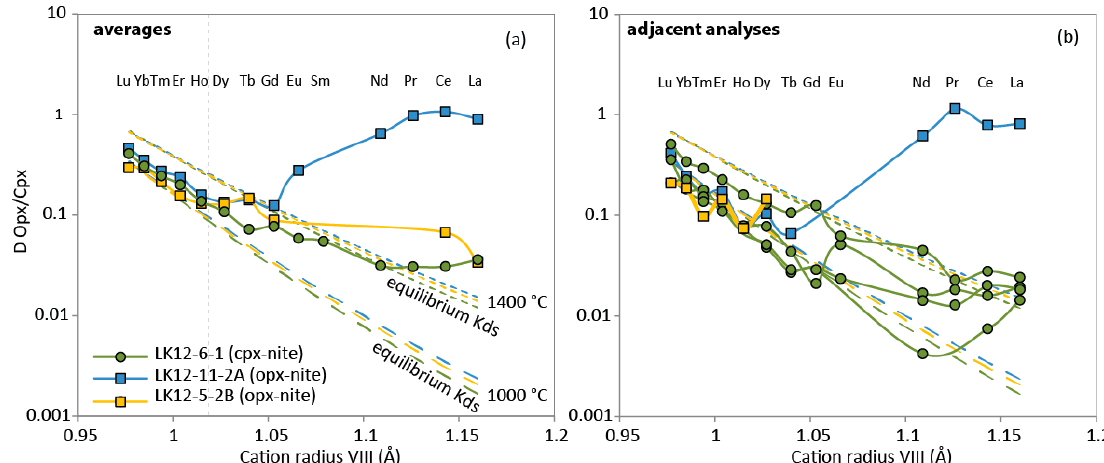
Figure 8. Apparent partition coefficients between OPX and CPX versus ionic radii of REE for ( a ) average compositions of all grains, and ( b ) adjacent analyses only. When multiple adjacent OPX-CPX pairs are available, multiple lines are reported for the same sample (e.g., LK12-6-1). Theoretical equilibrium Kds are calculated at 1000 °C and 1400 °C for comparison [48,49].